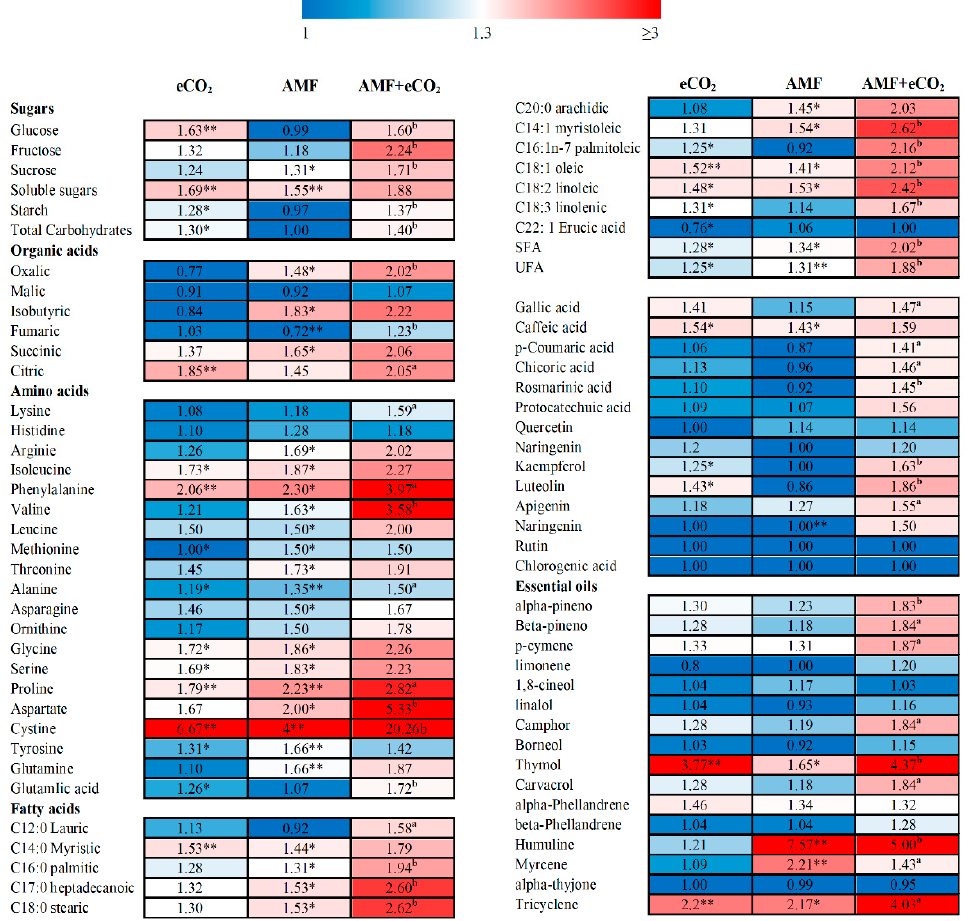
Figure 2. Heatmap of fold change in the contents of primary and secondary metabolites of Thymus vulgare grown under the e ff ect of eCO 2 (620 ppm), AMF or their combination (AMF-eCO 2 ). Asterisks indicate significant (* p < 0.05; ** p < 0.01) increased fold changes compared to control (untreated plants), as revealed by Student’s t-test. Lowercase letters indicate significant di ff erences ( a p < 0.05; b p < 0.01) between AMF alone and the combined AMF + eCO 2 treatment.